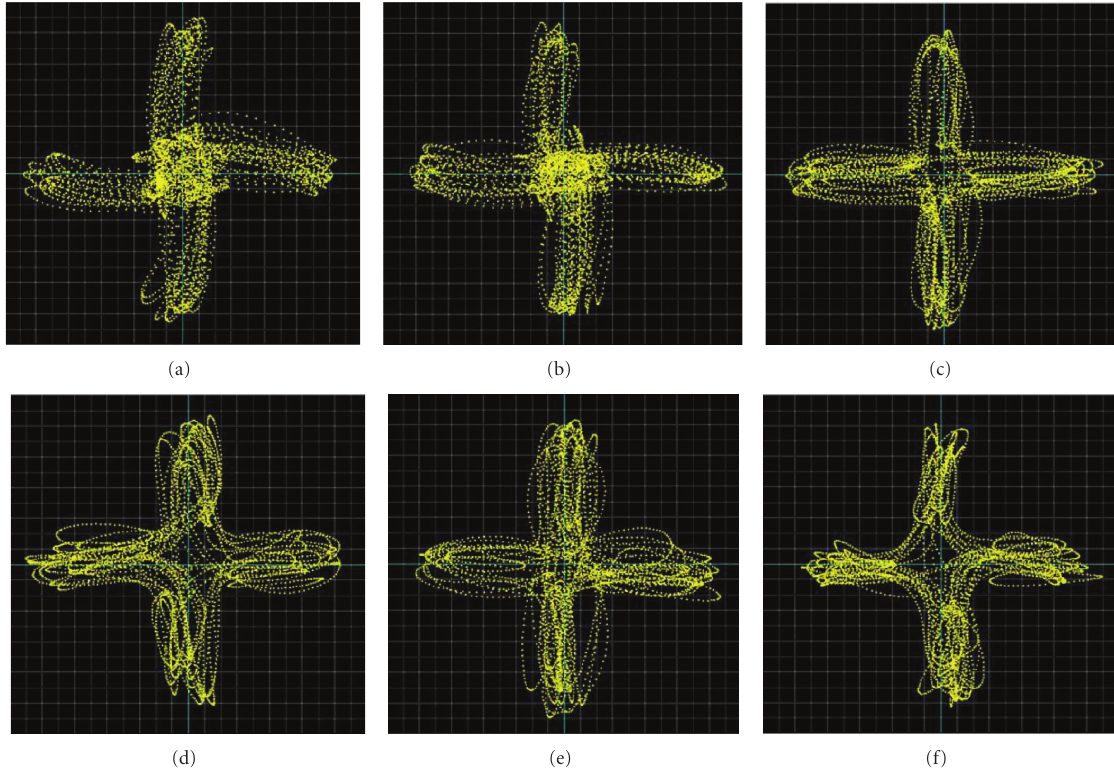
Figure 16: Constellation diagrams for 100Gbit/s DQPSK data exchange. (a) S1: back-to-back. (b) S2: back-to-back. (c) S1 after wavelength conversion (WC: S2 to S1) (S1: OFF, S2: ON). (d) S2 after wavelength conversion (WC: S1 to S2) (S1: ON, S2: OFF). (e) S1 after data exchange (Ex.: S2 to S1) (S1: ON, S2: ON). (f) S2 after data exchange (Ex.: S1 to S2) (S1: ON, S2: